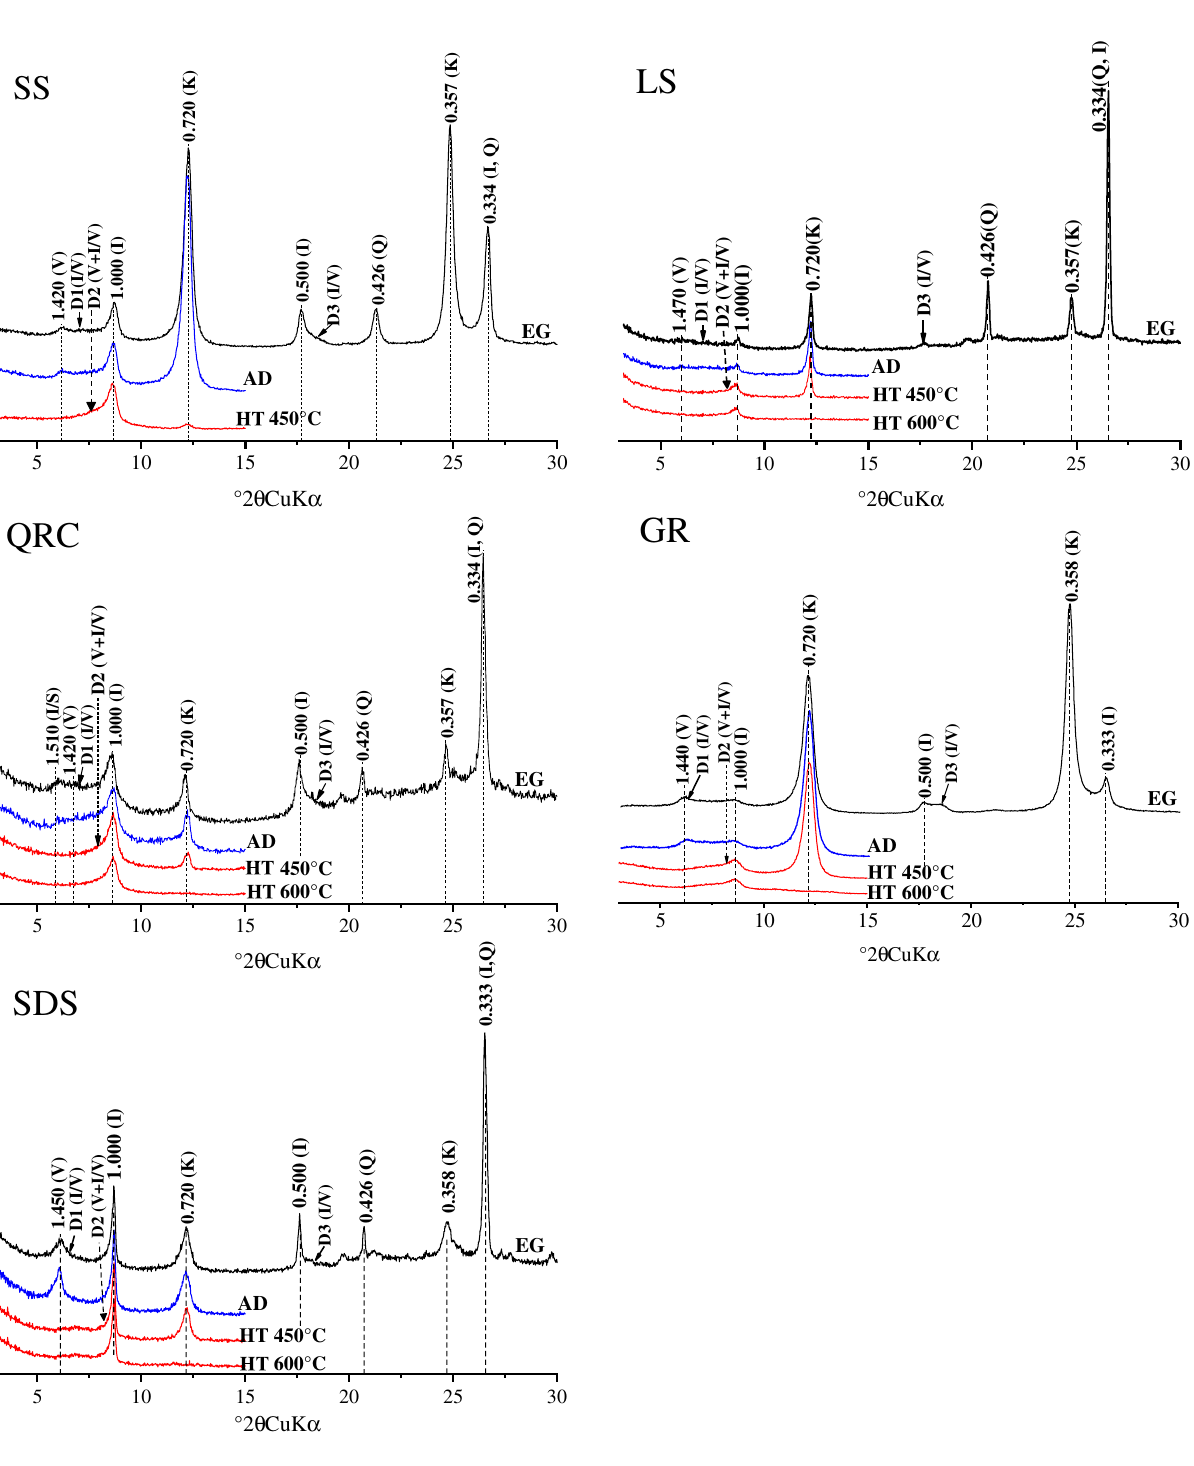
and I/V mixed-layer minerals (26%) were predominant in QRC, whereas vermiculite was less dominant (4%). In SS, the kaolinite and illite content varied substantially. The kaolinite content (43%) in SS was higher than that in QRC, but the content of illite (20%) and mixed-layer minerals (24%) was lower. In SS, the relative content of